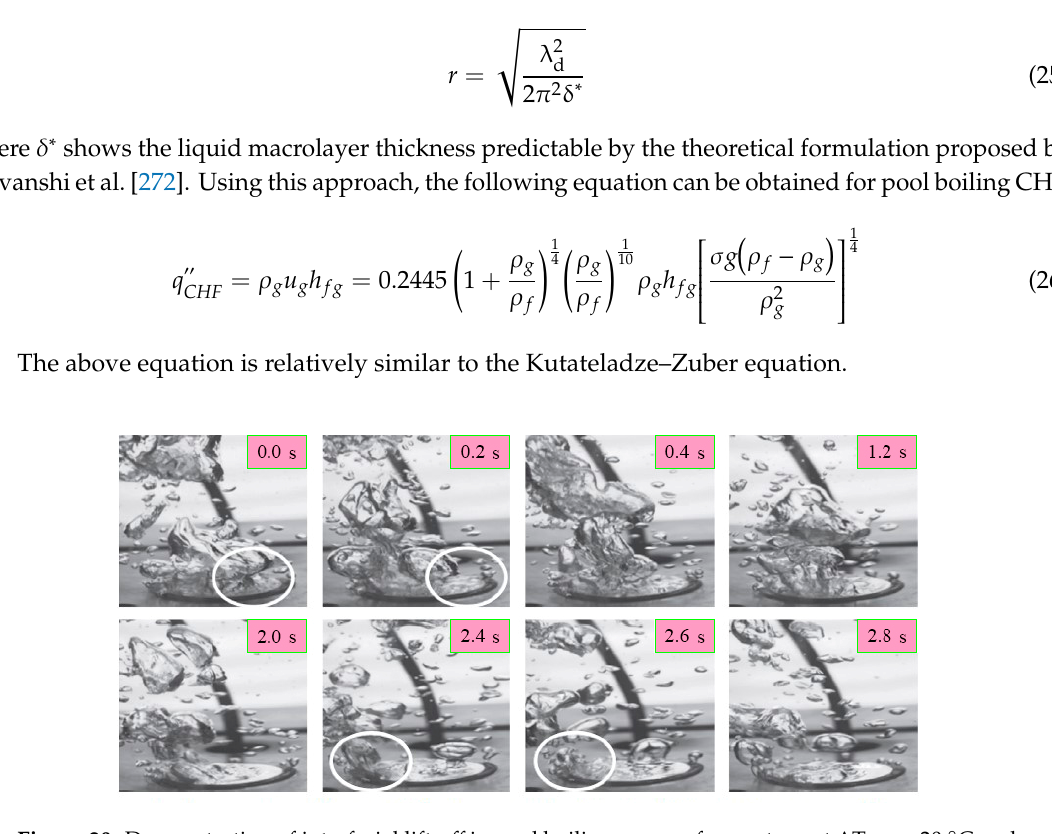
Figure 19. Pool boiling images and regions of various CHF mechanisms at diverse surface orientations. Adapted from Liang and Mudawar. Reproduced from [252], Elsevier: 2018.